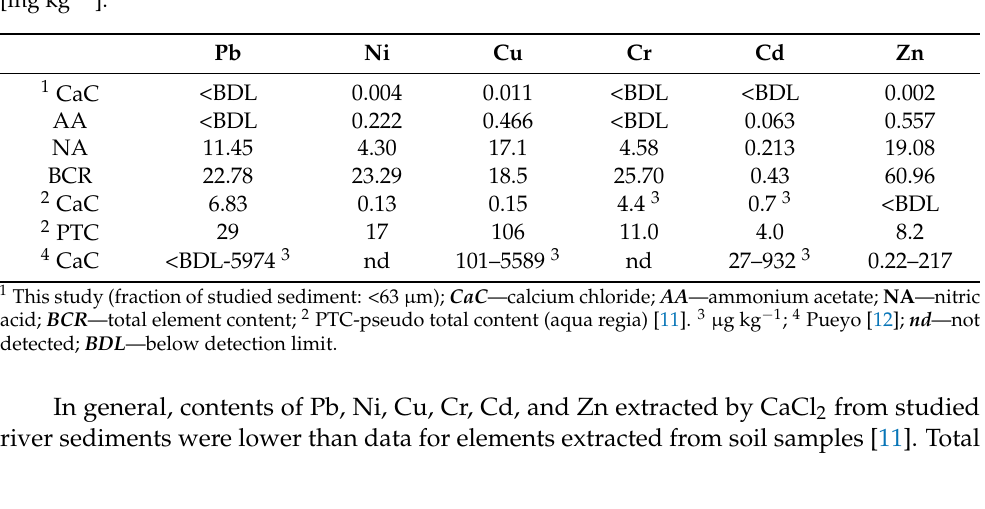
Table 6. Comparison of extracted elements content in this research with similar investigations [mg kg − 1